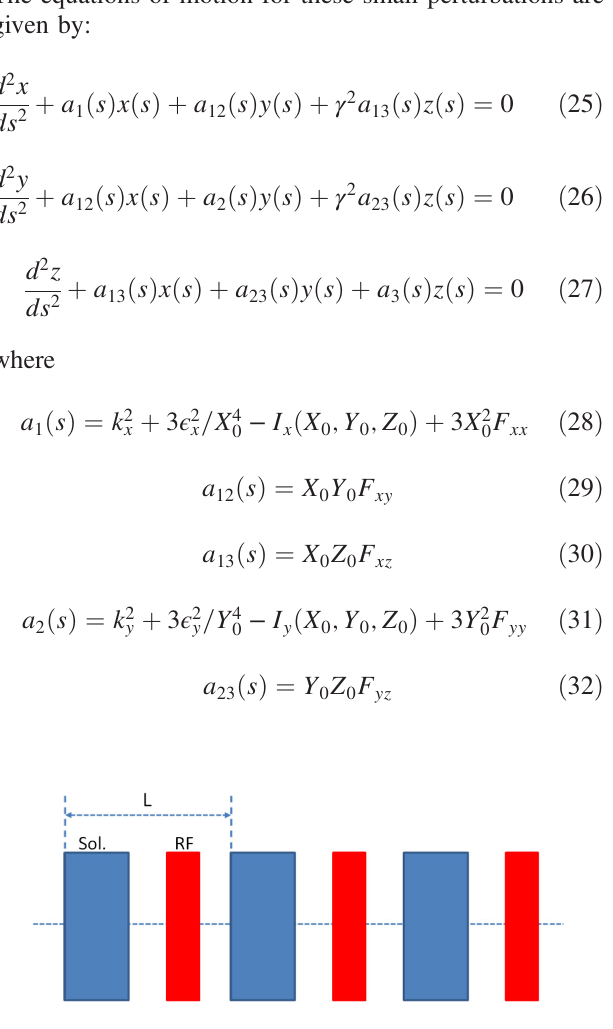
FIG. 1. Schematic plot of a periodic solenoid and rf